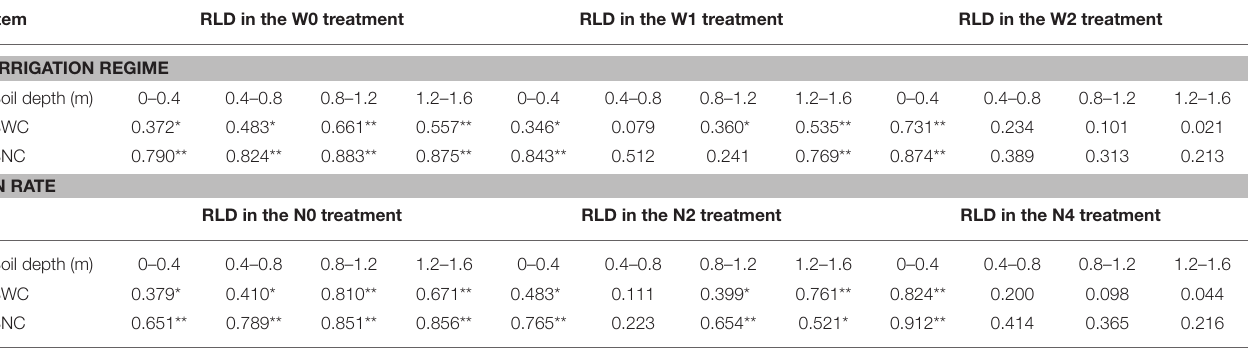
TABLE 6 | Correlation coefficients between root length density (RLD) and soil water consumption (SWC) and soil NO 3 -N content (SNC) at different soil depths. Item RLD in the W0 treatment RLD in the W1 treatment RLD in the W2 treatment IRRIGATION